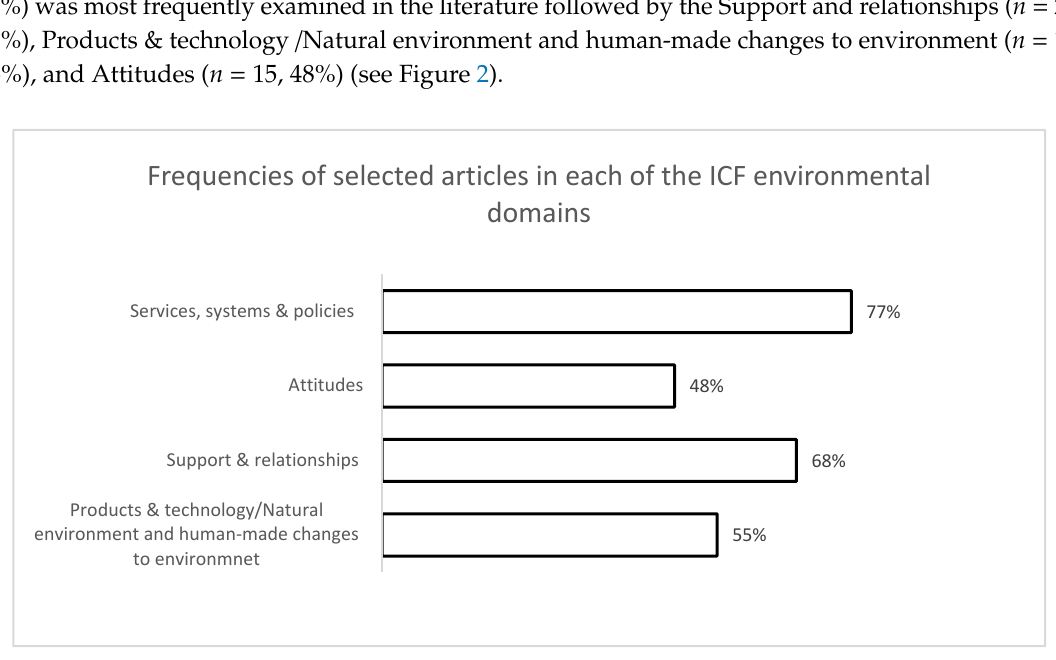
Figure 2. Frequencies of selected articles in each of the International Classification of Functioning, Disability and Health (ICF) environmental domains.